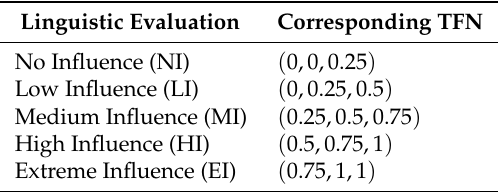
Table 1. Table 1. Fuzzy linguistic scale for the linguistic variable